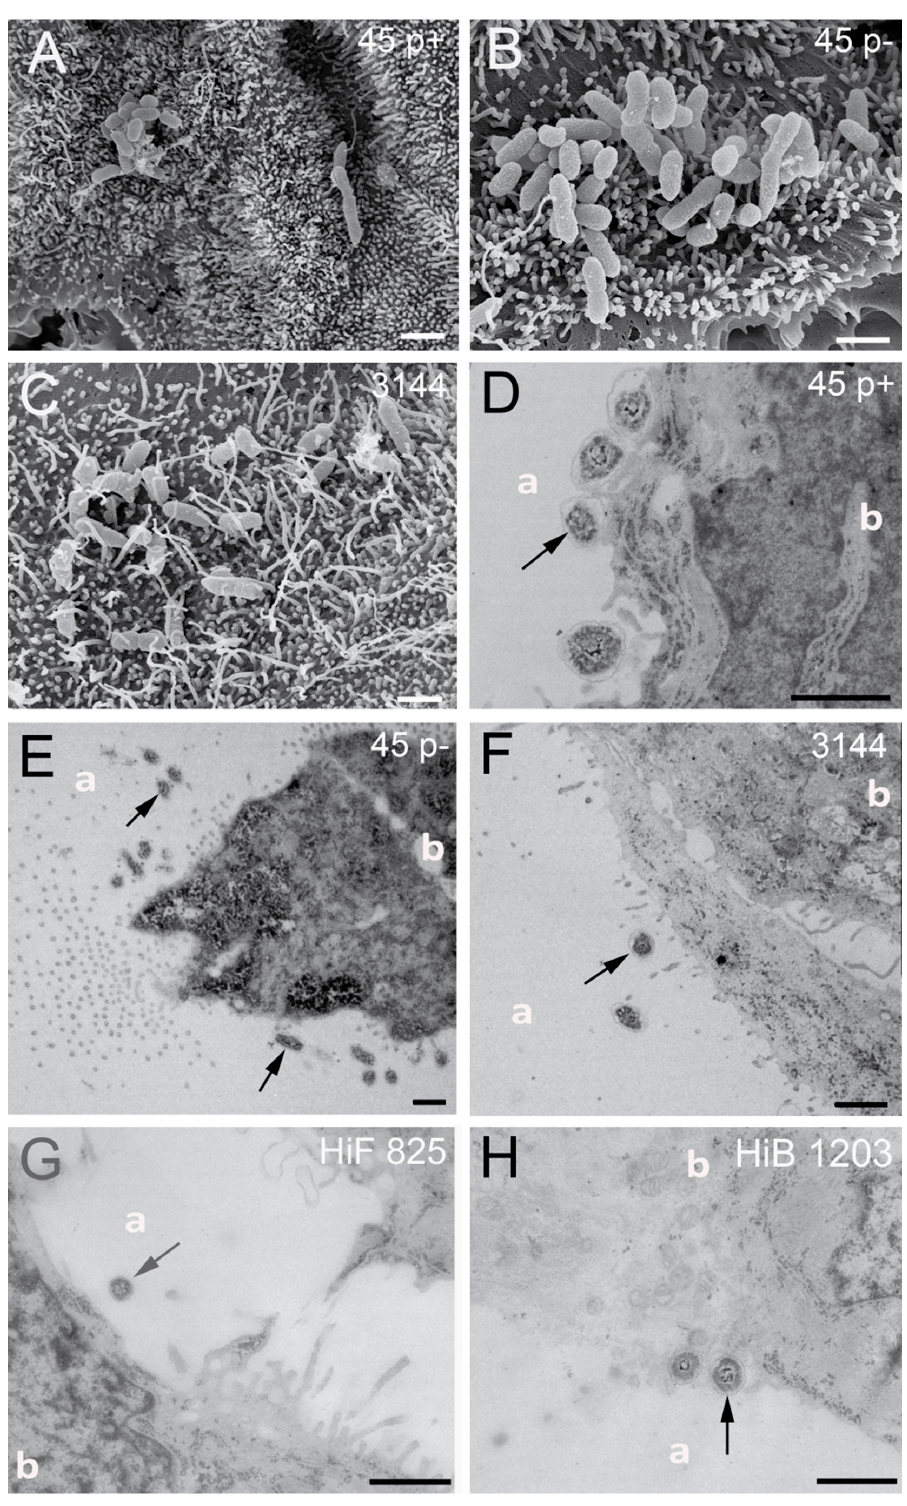
Figure 6. SEM and TEM sections of HIBCPP cells grown in the standard cell culture system infected with indicated NTHI and H. influenzae isolates for 6 h: ( A – C ) SEM images of NTHI strains 45 p+, 45 p- and 3144, which are located at the microvilli covered apical cell side; and ( D – H ) TEM images of bacteria adhering to the cells sitting on or next to microvilli of the HIBCPP (black arrows). Almost no intracellular bacteria could be detected in the standard culture grown HIBCPP cells. The apical and basolateral cell sides are labeled with “a“ and “b”, respectively. Scale bars represent 1 µ